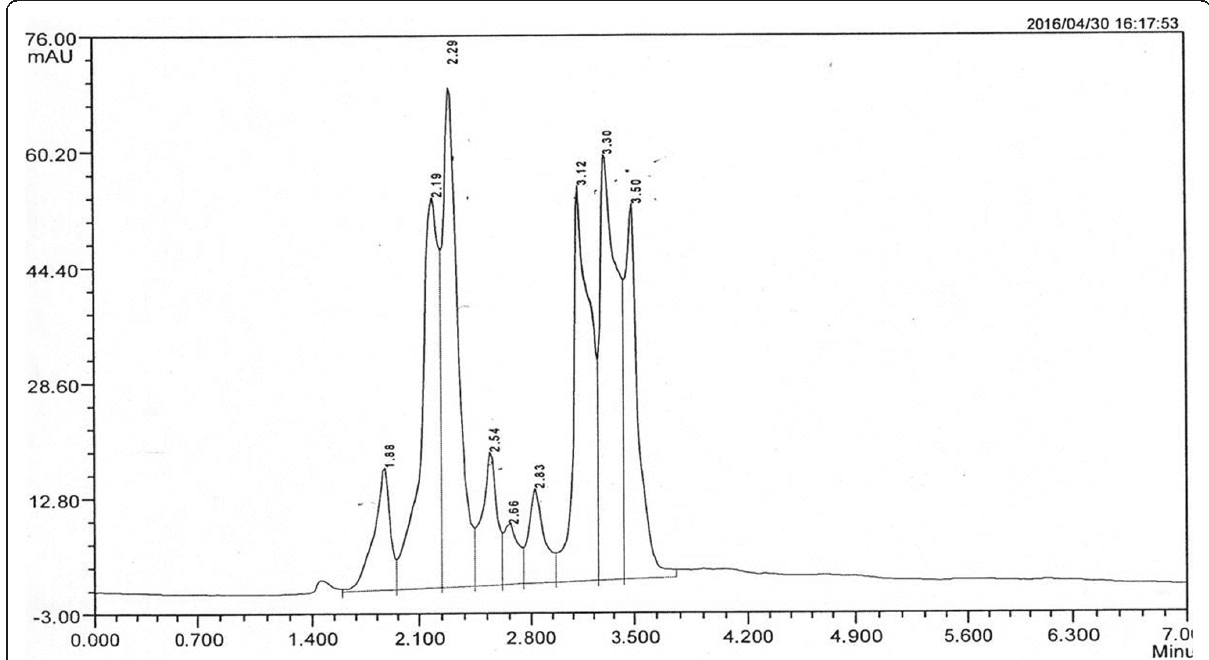
Fig. 3 HPLC chromatogram of BNF-LCME BNF-LCME: Butanone fraction of methanolic extract of Lindernia